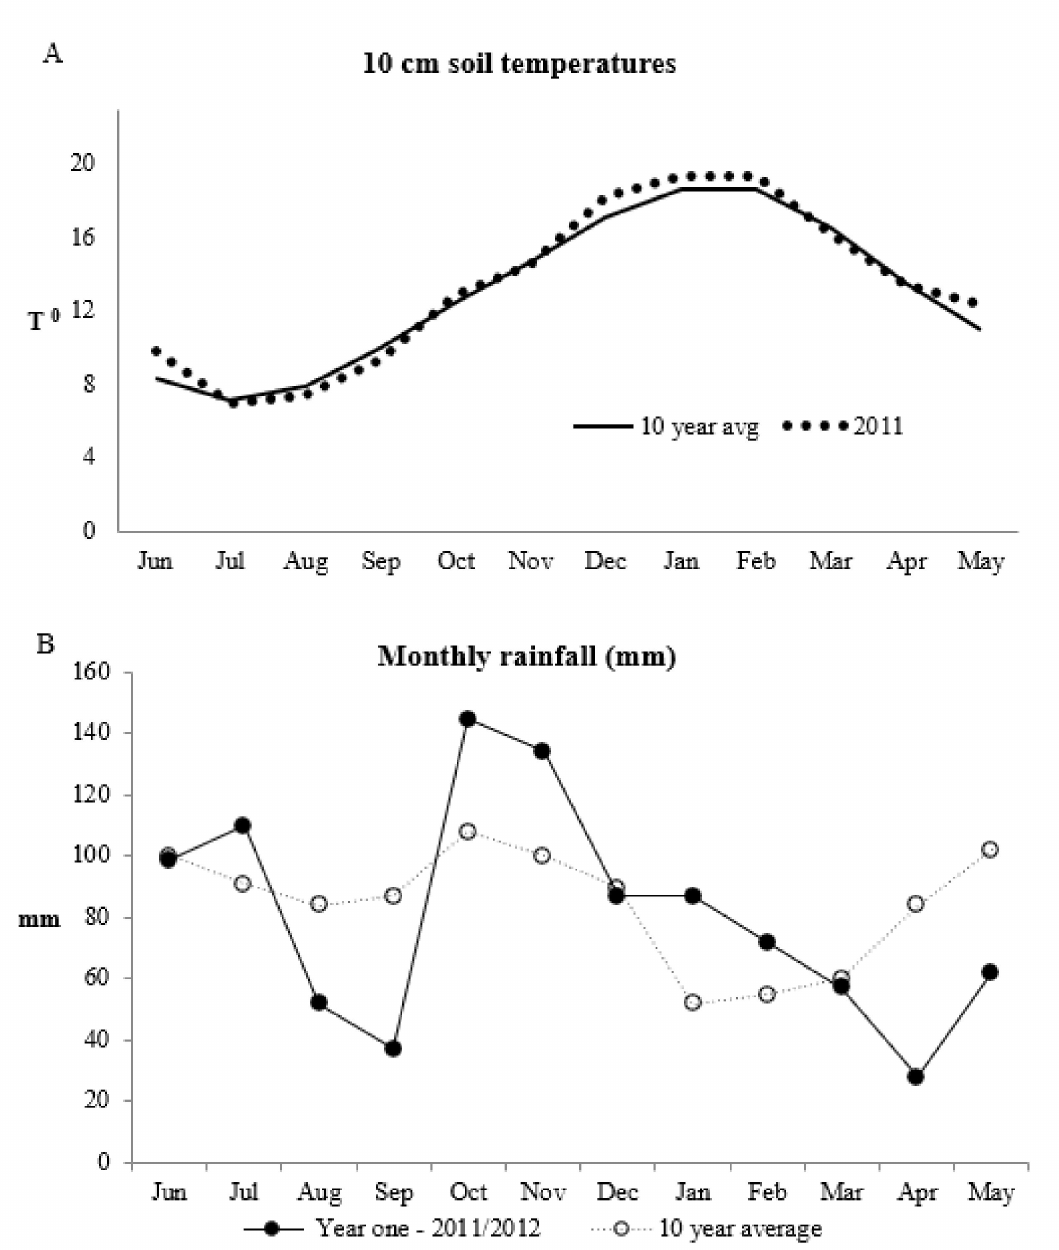
Figure 1. ( A ) Soil temperature ( ◦ C) and ( B ) rainfall (mm) at the experimental site for 2011 and the 10 year